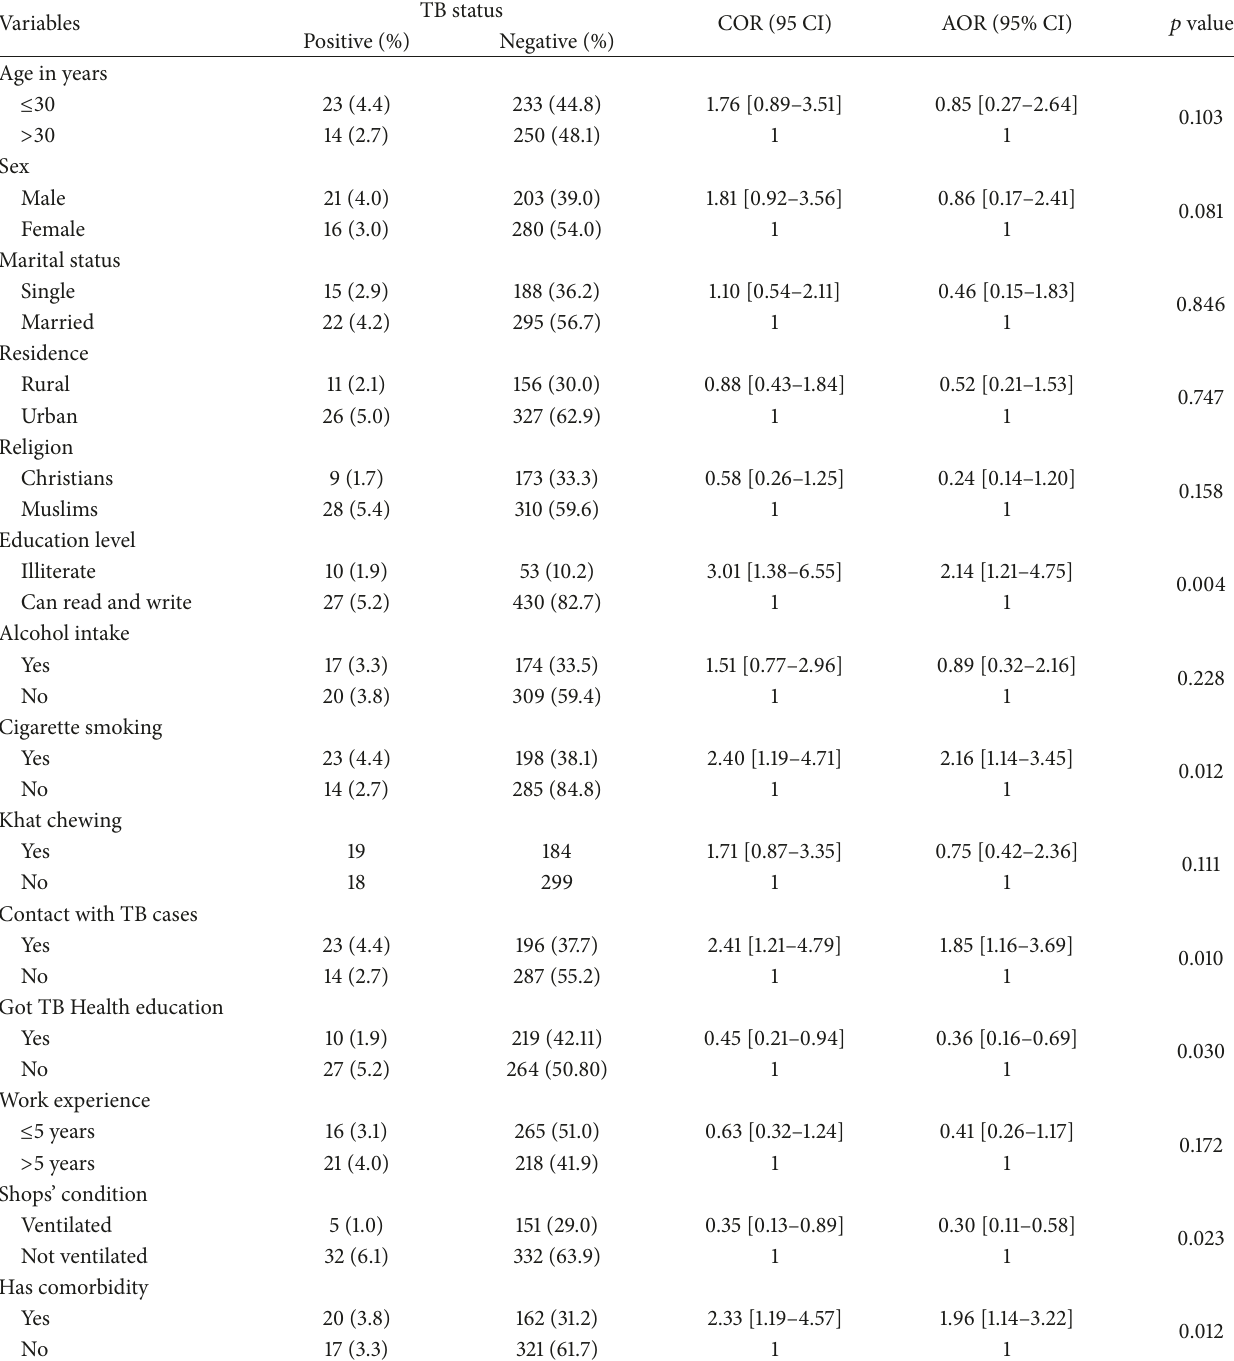
Table 2: TB infection and its determinant factors among shopkeepers in Bahir Dar City, Ethiopia,